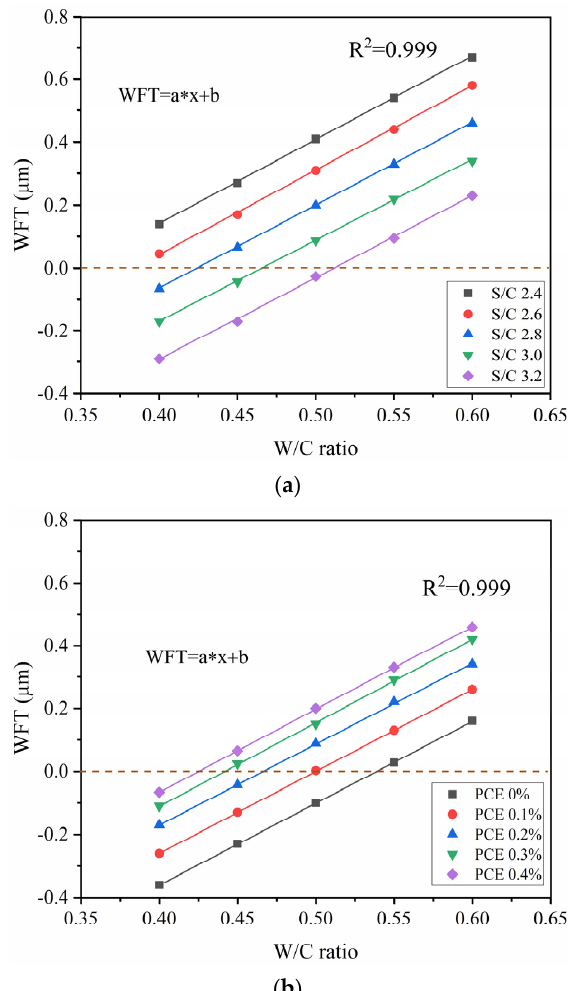
Figure 4. WFT versus W/C ratio: ( a ) different S/C ratios, ( b ) different PCE dosages.